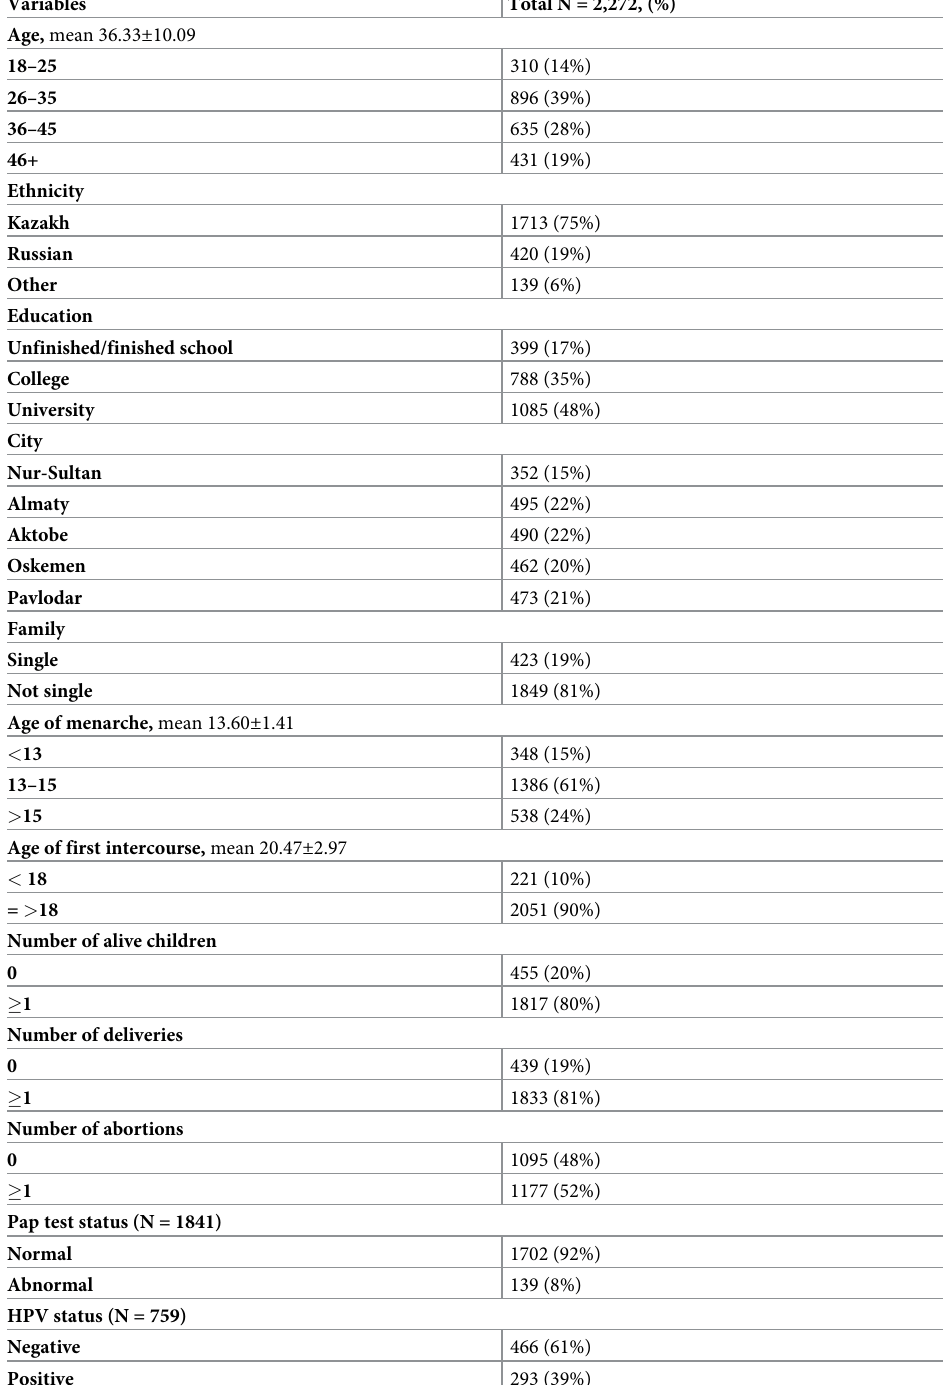
Table 1. Demographic and clinical characteristics of women visiting gynecological clinics, (N =